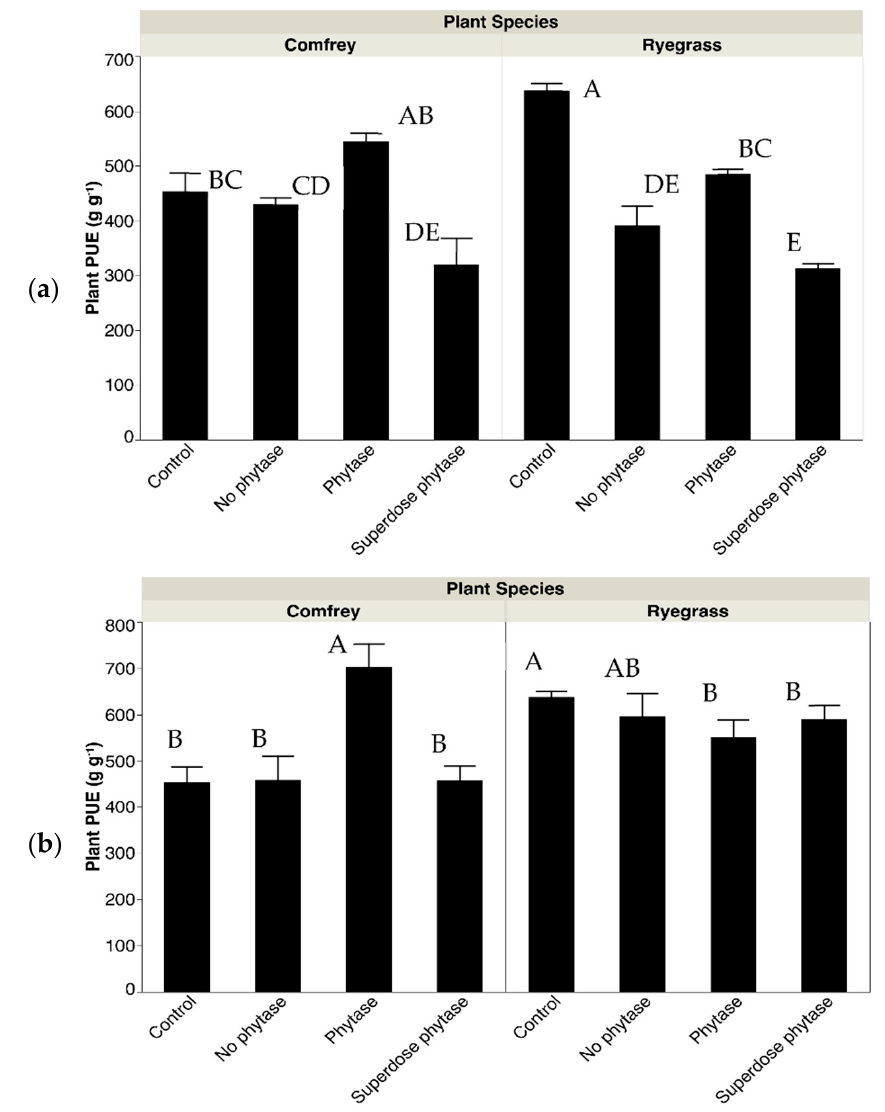
Figure 2. Effects of two different organic amendments ( a ) pig slurry and ( b ) broiler litter from different animal diets on plant phosphorus use efficiency (PUE) of two different plant species comfrey ( Symphytum × uplandicum ) and Italian ryegrass ( Lolium multiflorum ). Animal diets include: control = only inorganic fertiliser applied once (i.e., one dose of triple super P initially applied to support seedling growth), no-phytase, phytase and superdose phytase. Different letters indicate significant differences among treatments (Tukey HSD test).